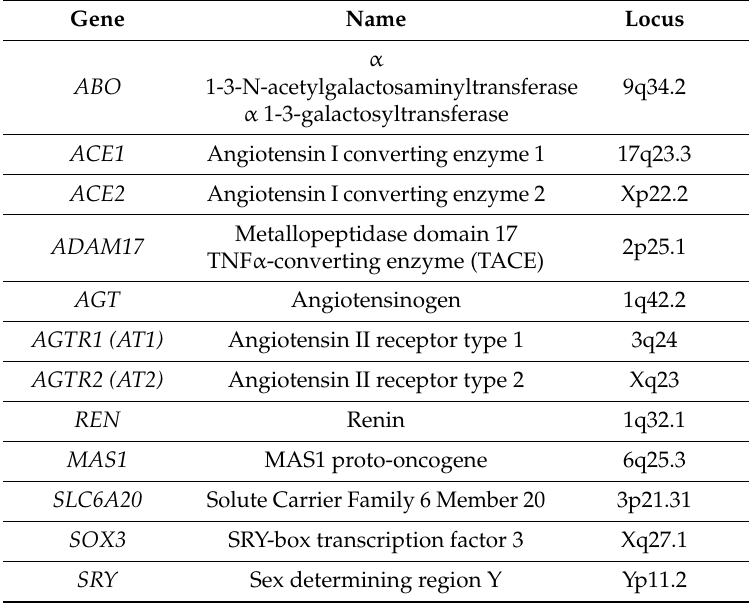
Table 2. Main genes directly or indirectly involved in the RAS pathway and in salt / water homeostasis. Gene Name Locus